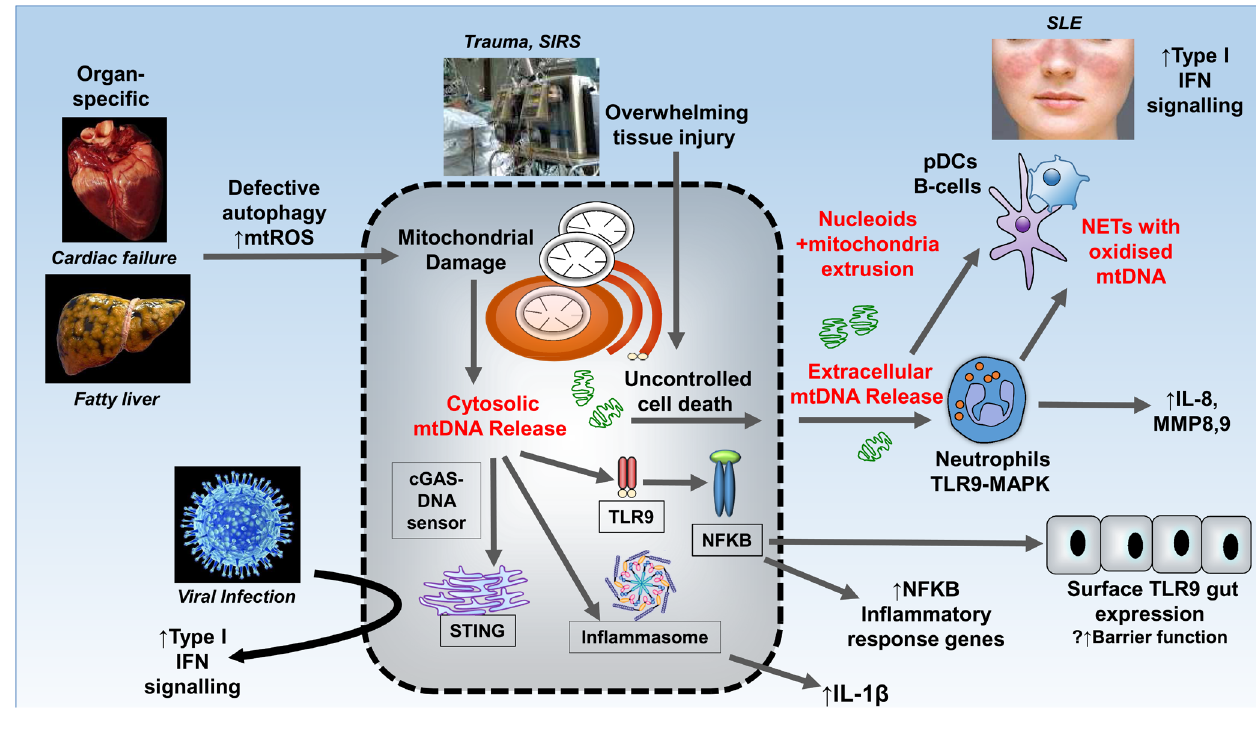
Figure 1. The contribution of mitochondrial DNA to disease pathogenesis. Medical conditions are in italics. Where and how mitochondria are released are indicated in red. Box in dotted line frames mitochondrial DNA (mtDNA) sensor target. cGAS, cyclic GMP-AMP synthetase; IFN, interferon; IL, interleukin; MAPK, mitogen-activated protein kinase; MMP, matrix metalloproteinase; mtROS, mitochondria-derived reactive oxygen species; NET, neutrophil extracellular trap; NF κ B, nuclear factor kappa B; pDC, plasmacytoid dendritic cell; SIRS, systemic inflammatory response syndrome; SLE, systemic lupus erythematosus; STING, stimulator of interferon genes; TLR9, Toll-like receptor 9.